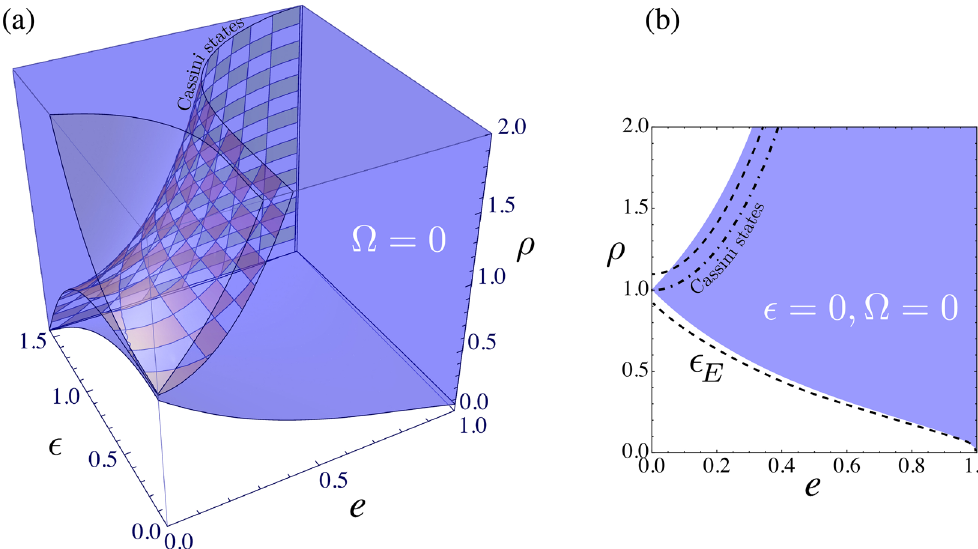
Figure 5. Obliquity and reversals. ( a ) 3D region where eccentricity e , spin–orbit ratio ρ = ω s /ω o , obliquity ǫ , and nodal angle (cid:31) = 0 cause apparent solar reversals. Checkered surface indicates Cassini states. ( b ) 2D cross sections at ǫ = 0 (solid blue) and Earth’s ǫ E = 0.4 (dashed black lines) show that small tilts only weakly affect the reversals. Dot-dashed curve indicates Cassini states.